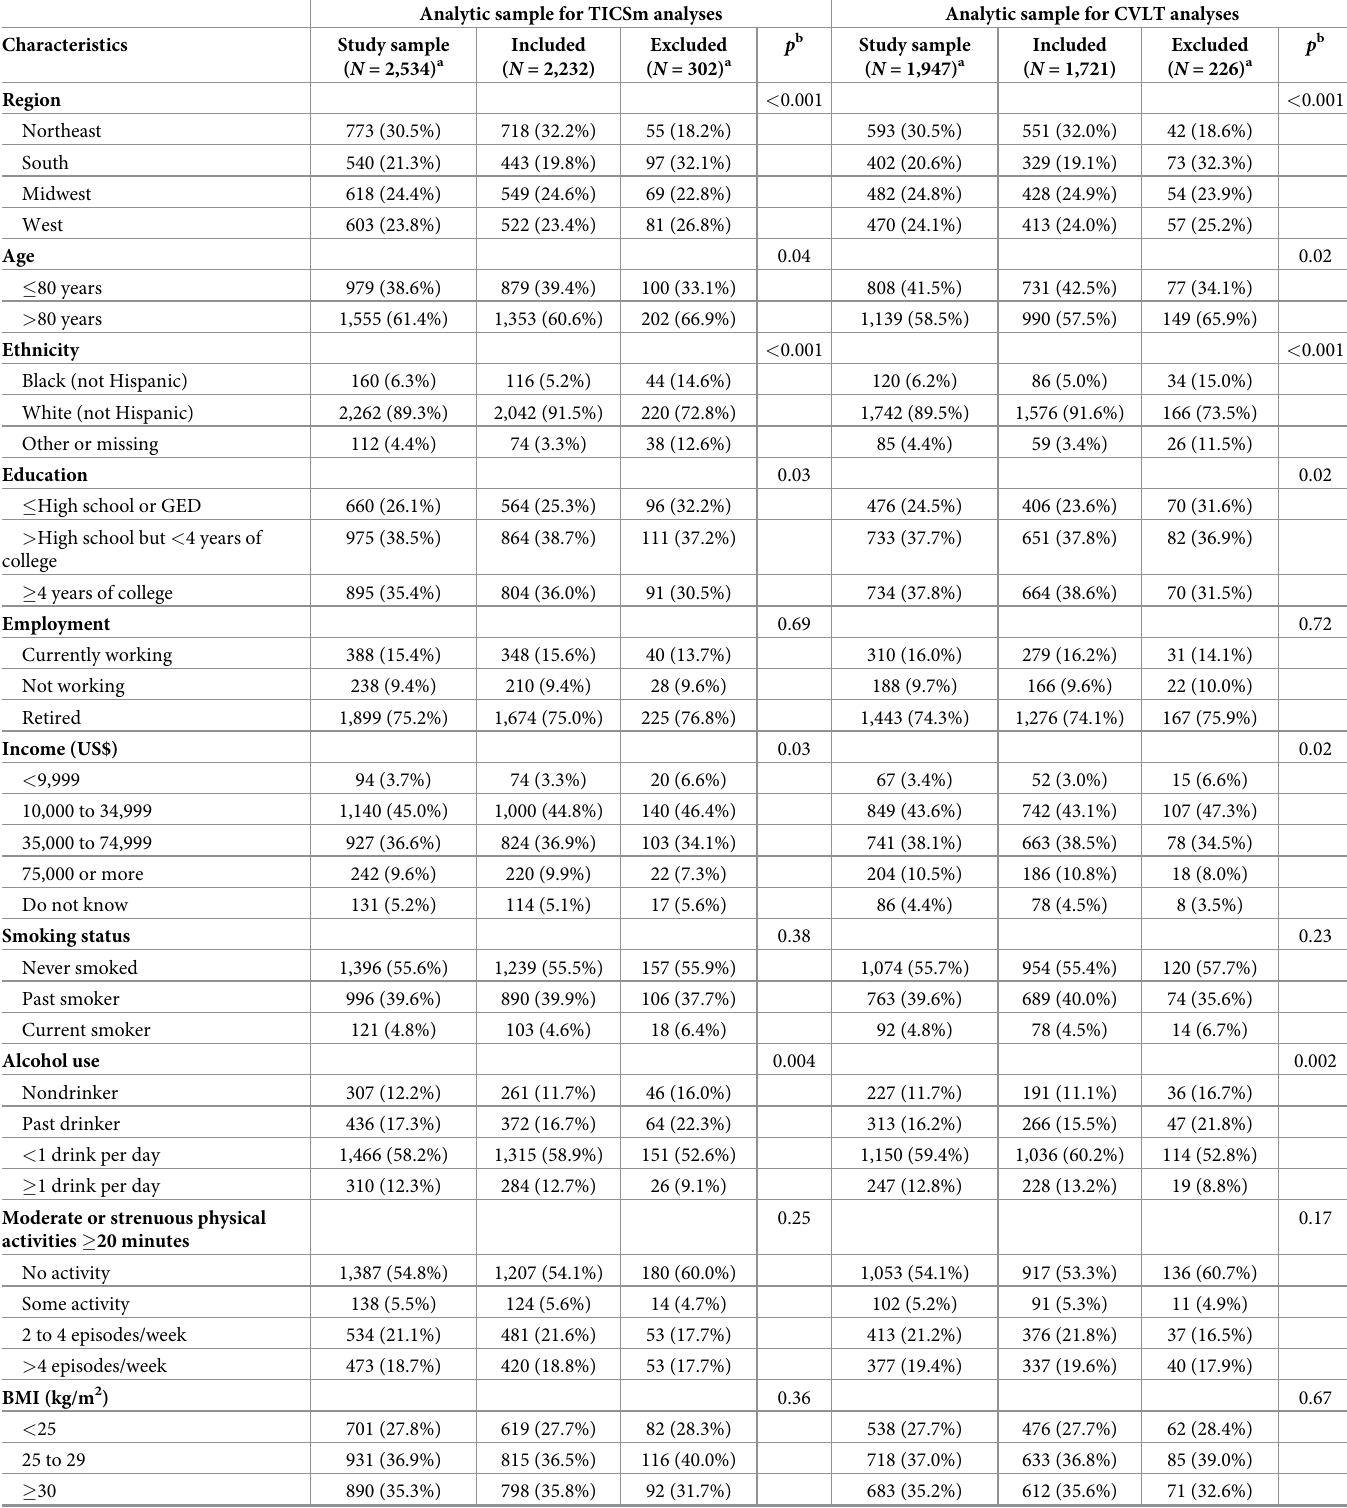
Table 1. Distribution of population characteristics in the WHIMS-ECHO cohort, stratified by women included versus excluded. Analytic sample for TICSm